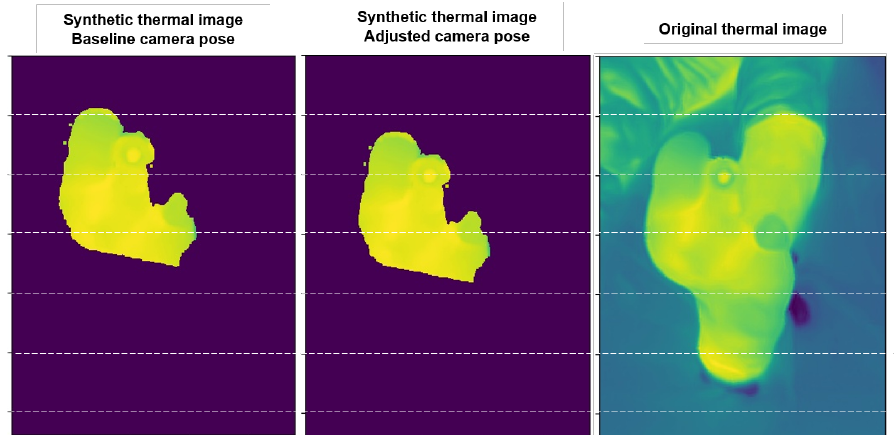
Figure 6. Illustration of synthetic thermal images created by projecting the reference view model using the baseline ( left ), the adjusted IR camera pose ( center ), and the original thermal image ( right ). The dashed horizontal lines show that the synthetic images are in better alignment with the actual thermal image when the camera pose is